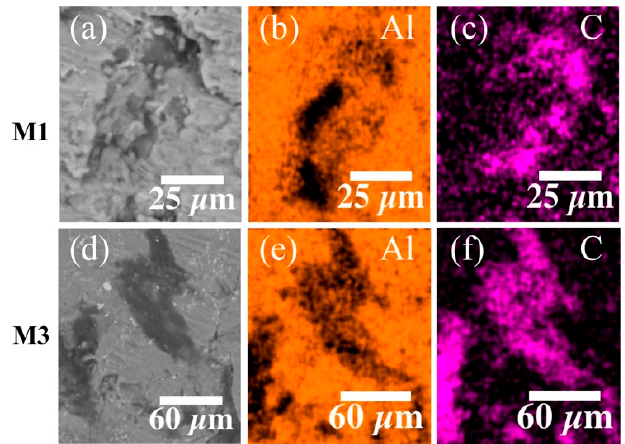
Figure 3. BSE-SEM micrographs ( a ), ( d ) and their corresponding energy dispersive spectroscopy (EDS) elemental mapping for Al ( b ), ( e ) and C ( c ), ( f ) performed in samples M1 and M3. The area of MWCNTs agglomerations increases considerably at higher wt%, as observed in sample M3.